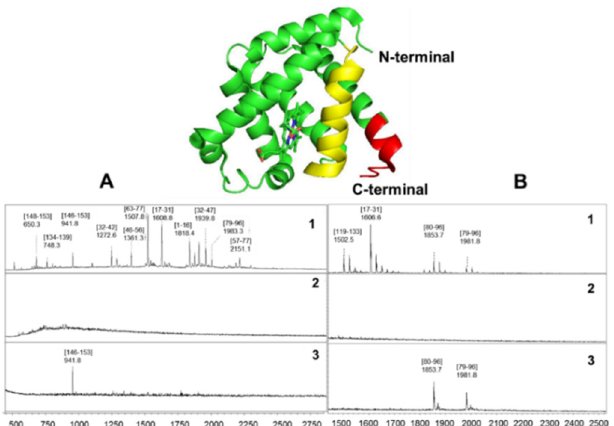
Figure 3. Identification of epitopes of horse heart myoglobin by chip-SPR-MALDI-MS with a monoclonal antibody ( A ) and a polyclonal antibody ( B ). Antibodies were immobilized by protein G- covalent fixation as described in Materials and Methods, and tryptic digest mixtures of myoglobin submitted on the chip. Sequence of MALDI spectra for each antibody denote the supernatant (1a), background after final washing (2), and elution with 0.01 M aqueous TFA (3). Epitope peptides identified are illustrated in the myoglobin structure, (146–153) for monoclonal (red) [38], and (79–96) for the polyclonal antibody (yellow).